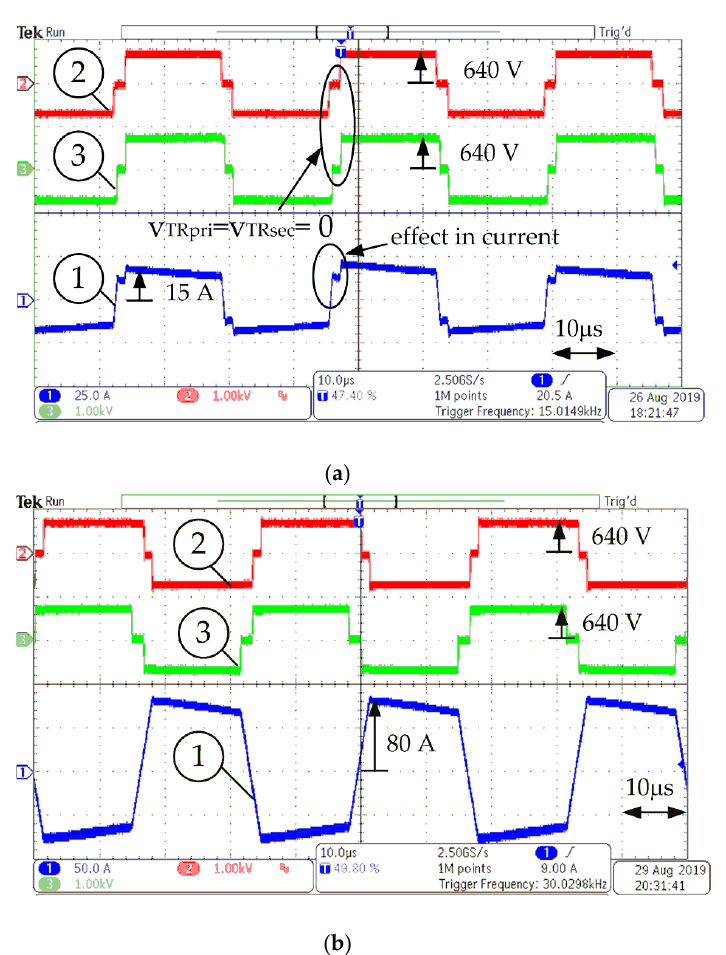
Figure 15. Measured waveforms of the DAB DC-DC converter with the second MFT prototype: primary transformer current i TR_pri (1), 25 A / div; primary voltage v TR_pri (2), 500 V / div; secondary voltage v TR_sec (3), 500 V / div at partial power of 10 kW ( a ) and the corresponding waveforms at power of 45 kW ( b ).